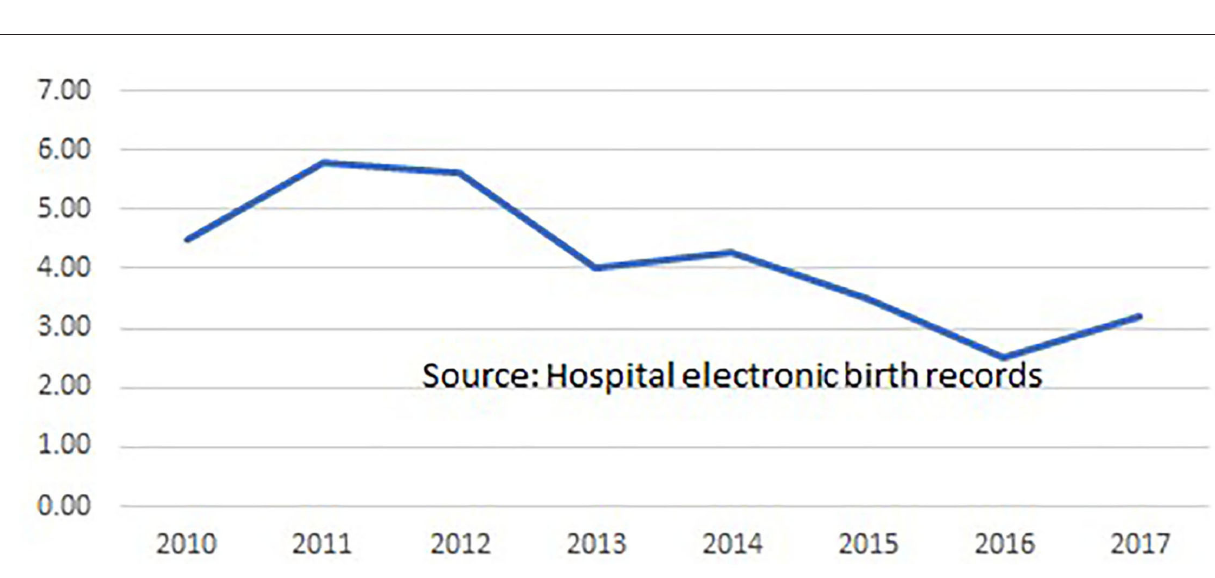
FIGURE 2 | Stillbirth rate per 1000 booked singleton pregnancies, 28 weeks gestation and above, in Fernandez Hospitals, 2010 to